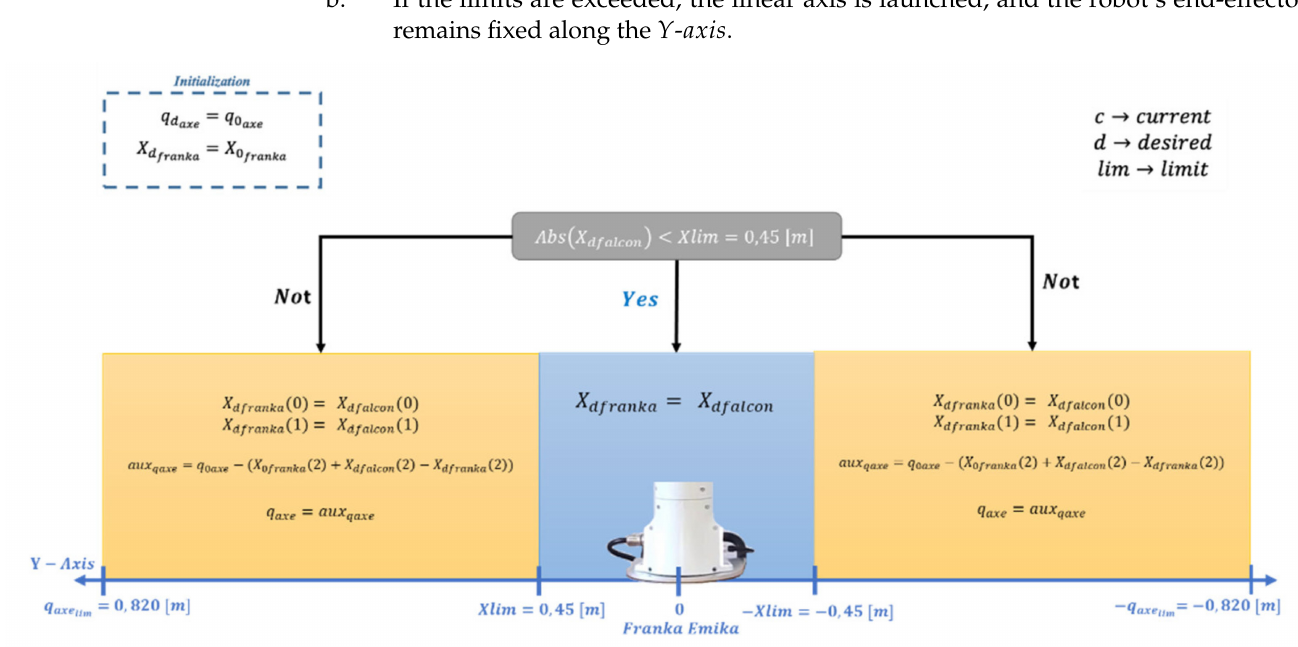
Figure 13. Movement distribution between the Franka Emika cobot and the linear axis in the pos_criteria